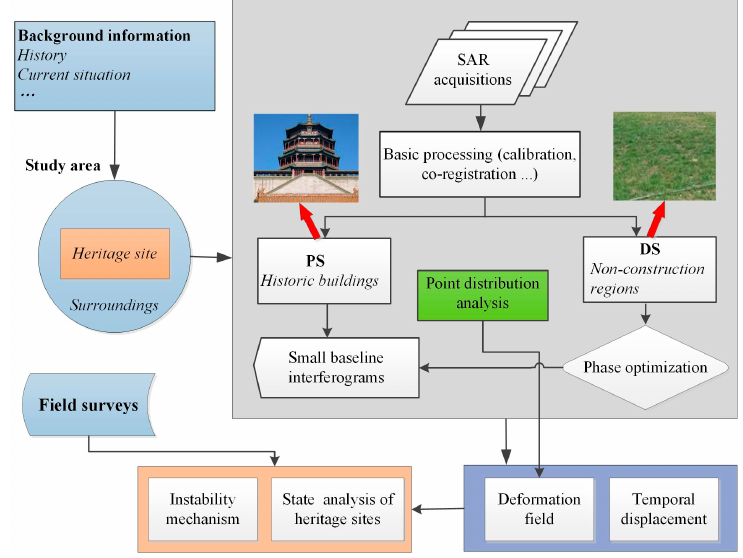
Figure 3. Flow chart of the data processing and interpretation for the monitoring of heritage sites using the advanced Multi-Temporal Interferometric Synthetic Aperture Radar (MTInSAR) approach.